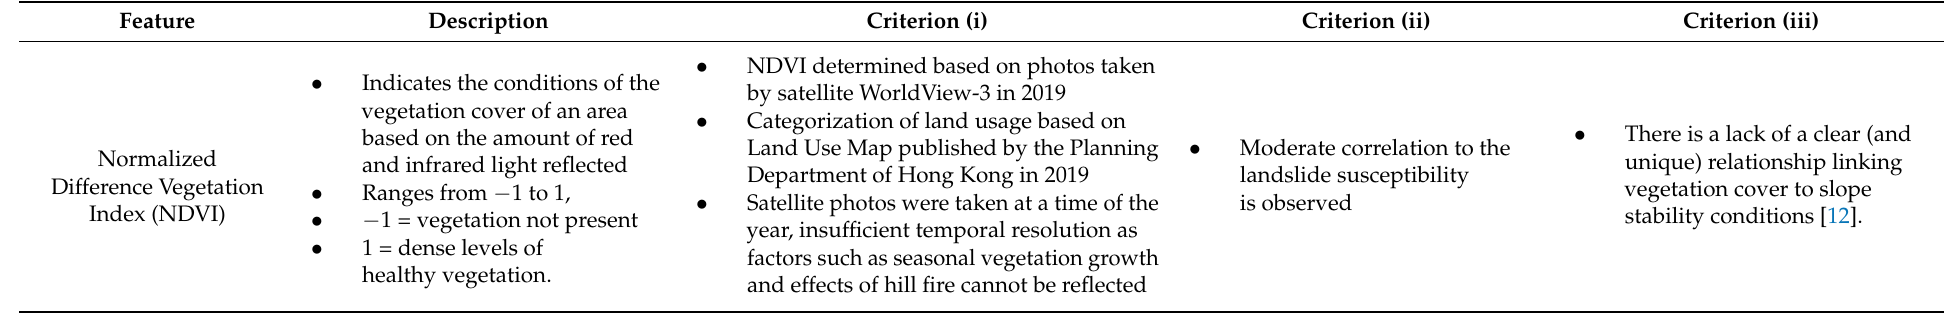
Table 5. Features not included in the Pilot Study after